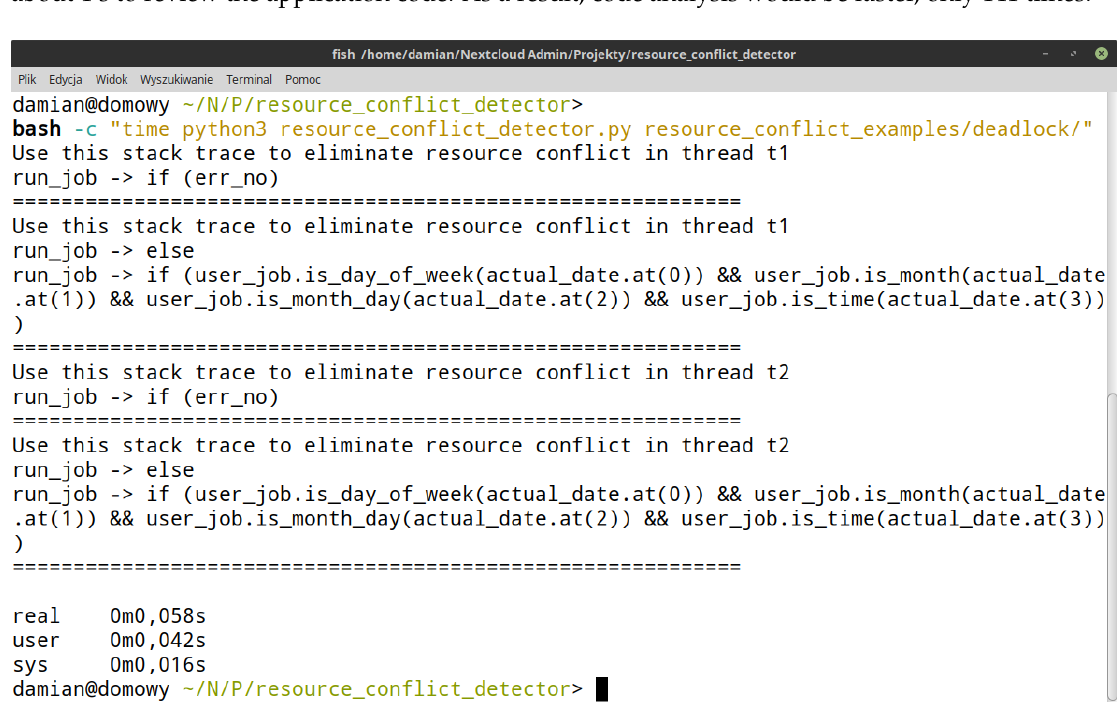
Figure 11. Screenshot of the console window with resource conflict detector (RCD) time to locate the deadlock in the AP1